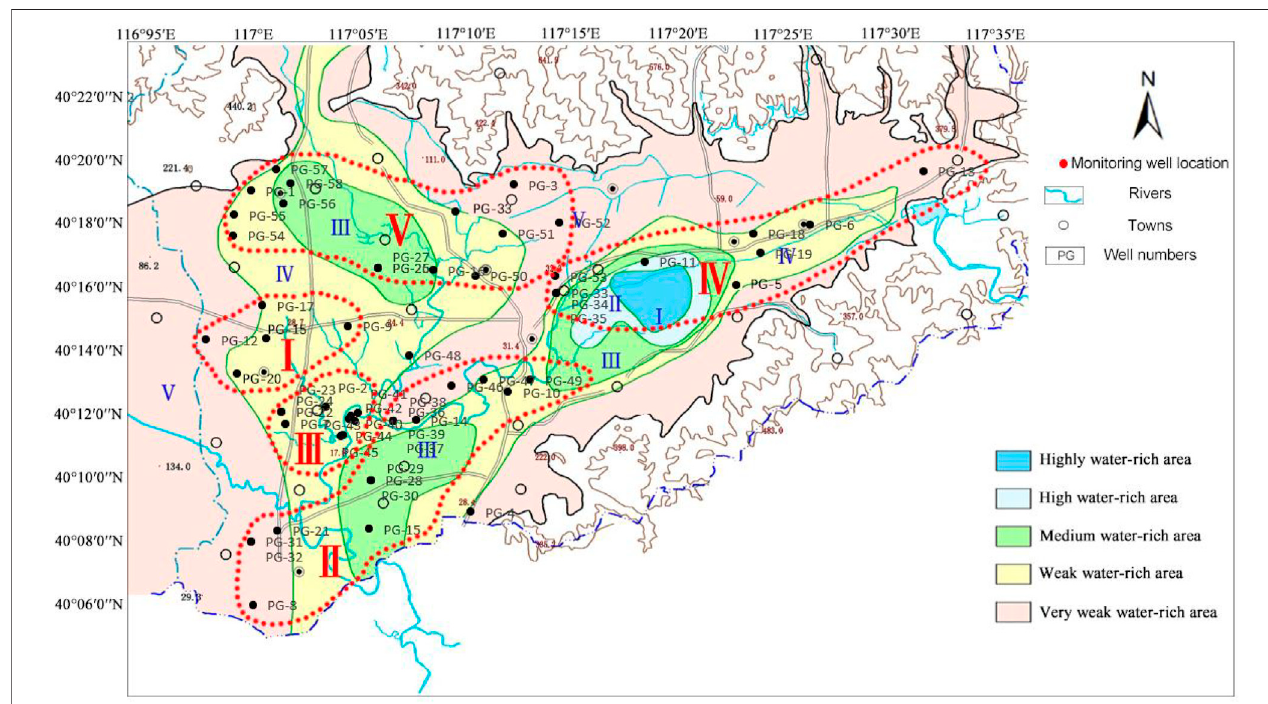
FIGURE 5 | Classi fi cation of the monitoring wells obtained through SOM.